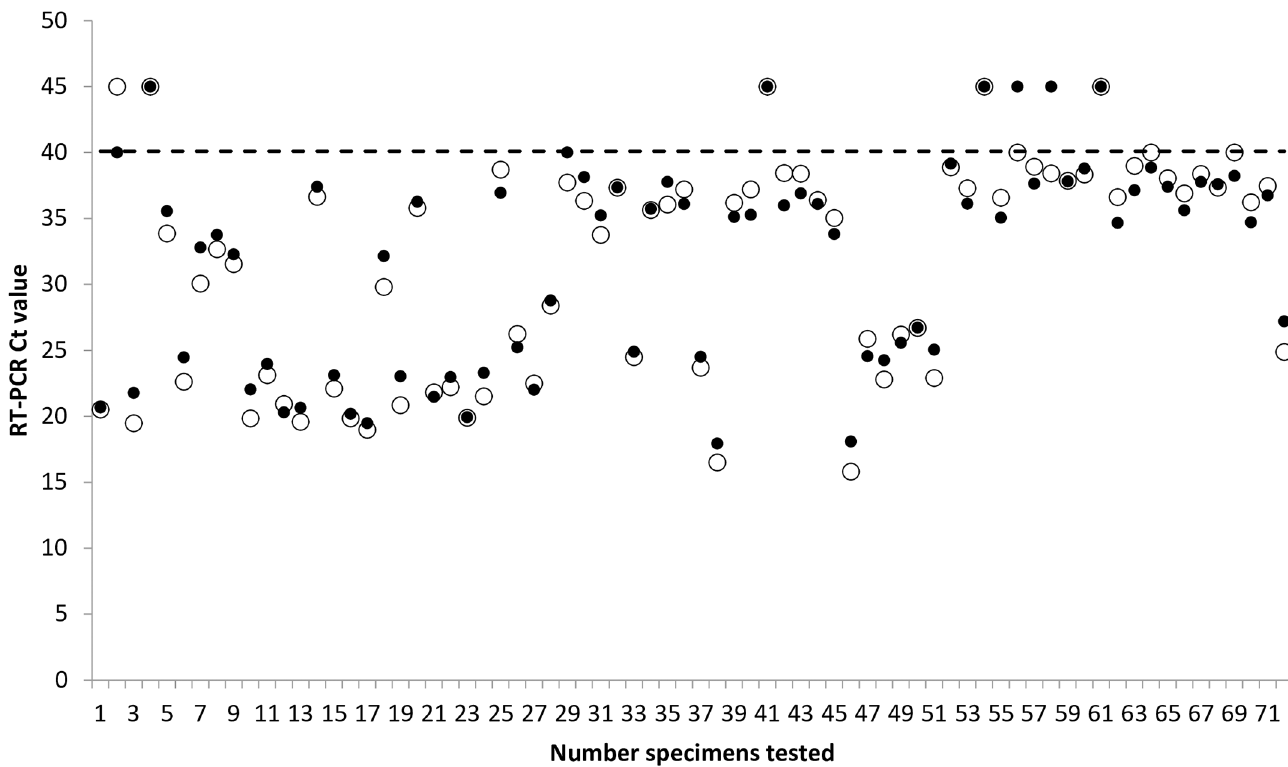
Fig 5. Results of EBOV L-gene RT-PCR in sera subjected to RNA manual (black dots) and automated (circles) extraction.